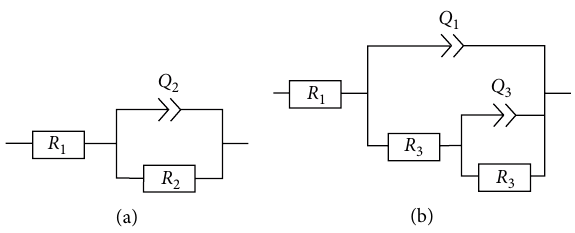
Figure 6: Equivalent circuits used to fit the EIS experimental